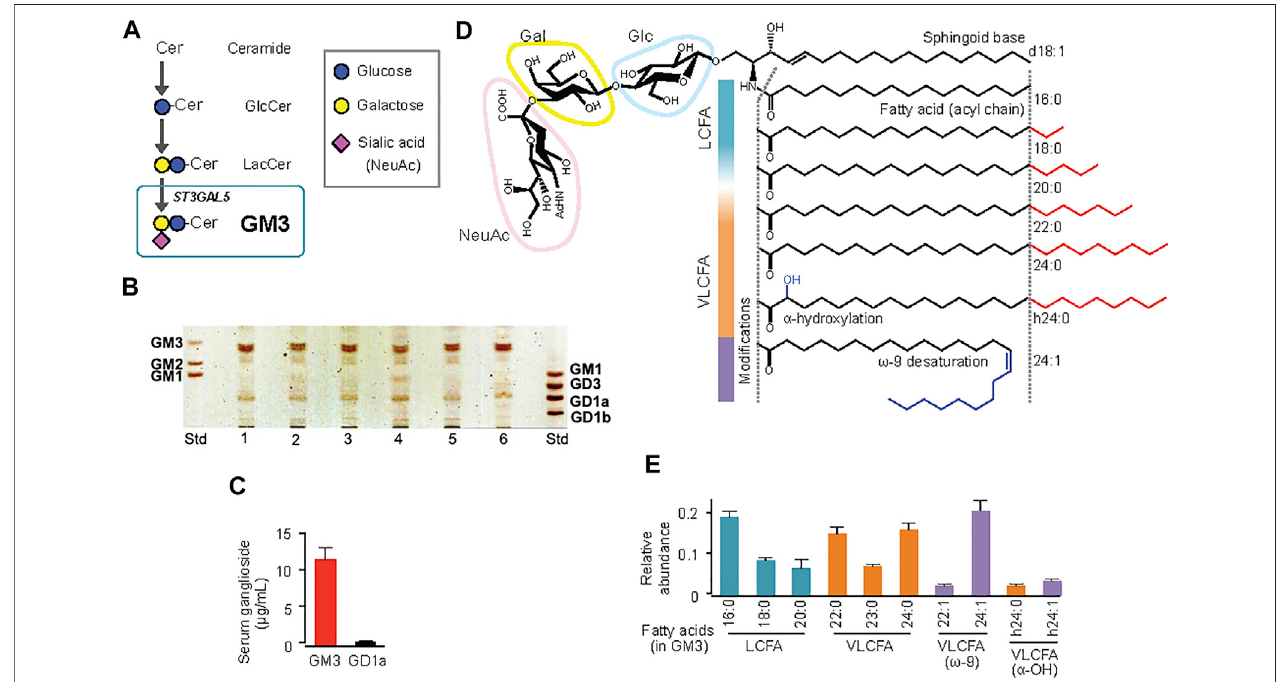
FIGURE 1 | Molecular species of ganglioside GM3 in human serum, and their acyl-chain structures. (A) Pathway (schematic) of GM3 biosynthesis from ceramide. (B) TLC analysis of ganglioside species in human serum. (C) Quanti fi cation by densitometry of major ganglioside species GM3 and GD1a in sera from healthy subjects ( n = 6). (D) Detailed structures ofGM3 species: sialyllactose head group, sphingoid base (d18:1), typical fatty-acid lengths (LCFA, VLCFA), and acyl-chain modi fi cations (a-hydroxylation, ω -9unsaturation). (E) Quanti fi cationbyLC-MS/MS ofserum GM3speciesinhealthysubjects.Totalabundanceof10representativespecieswas de fi ned as 1. (Kanoh et al., 2020).